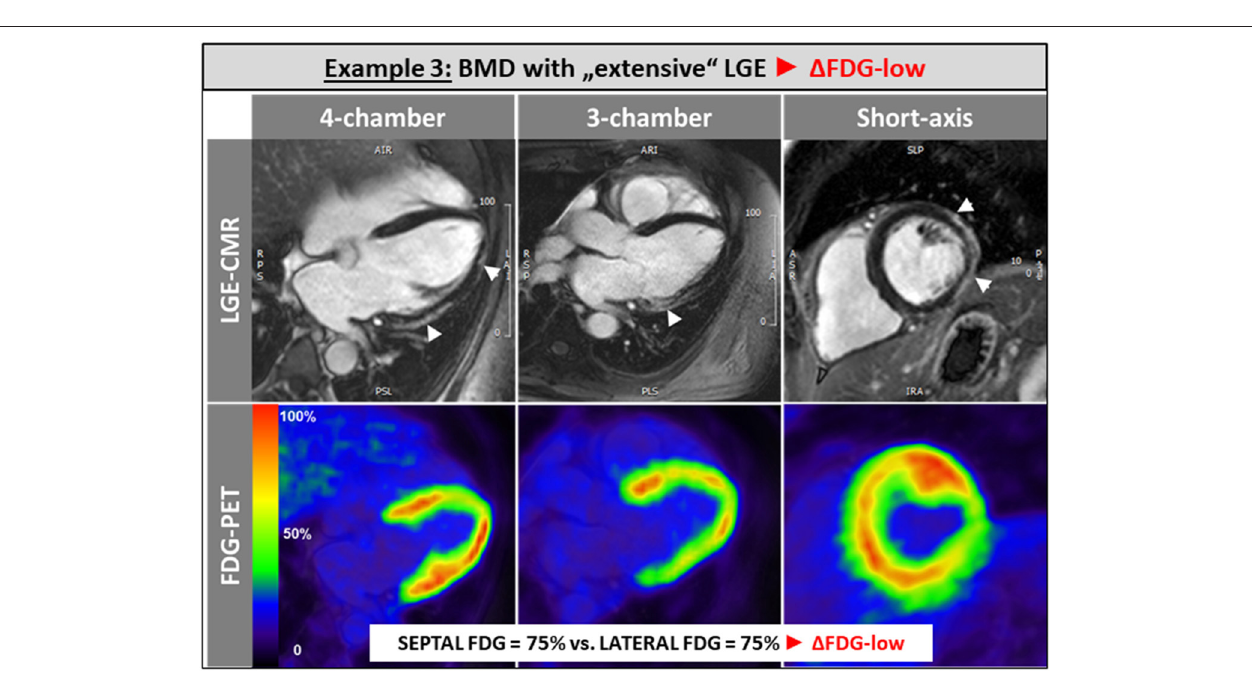
as long as myocardial scarring is limited, and (b) extensive and ongoing myocardial scarring in the LV free wall results in equalization of lateral vs. septal wall FDG uptake by a